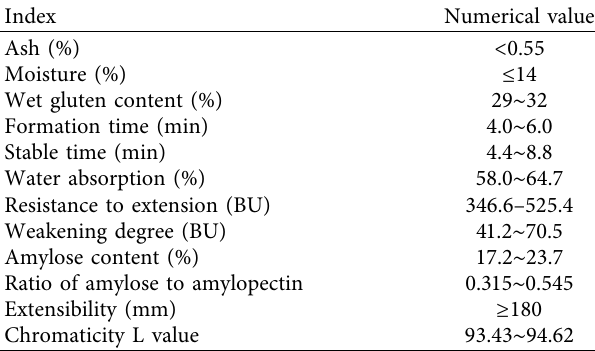
Table 9: Quality reference index of special flour for fried